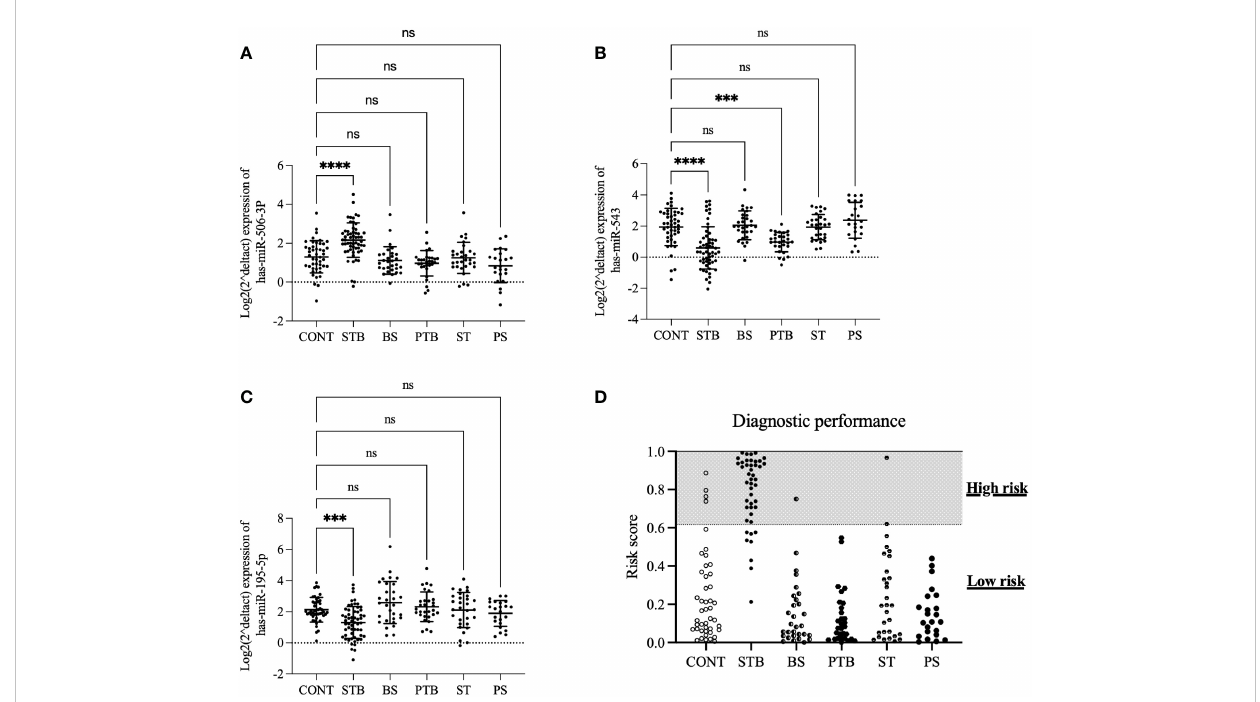
FIGURE 4 The expression pro fi les of 3 miRNAs and performance of the diagnostic model in the validation cohort. The expression levels of 3 miRNAs were assessed in the independent validation cohort, including CONT(n=45), STB(n=45), brucellosis spondylitis (BS, n=30), PTB (n=30), spinal tumor (ST, n=30) and pyogenic spondylitis (PS, n=23). (A) . hsa-miR-506-3p (B) . hsa-miR-543 (C) . hsa-miR-195-5p. A p-value was determined by the Kruskal- Wallis test (D) . the population of indicated groups was classi fi ed into high-risk and low-risk groups. ***P ≤ 0.001; ****P ≤ 0.0001; ns: P > 0.05.